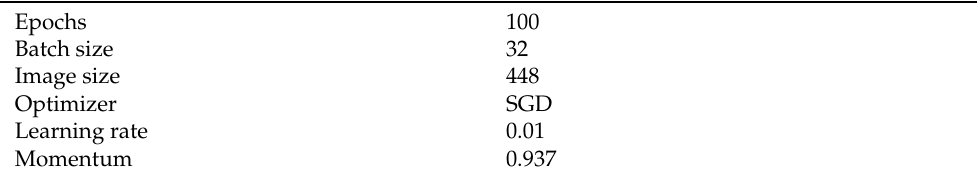
Table 2. Basic training